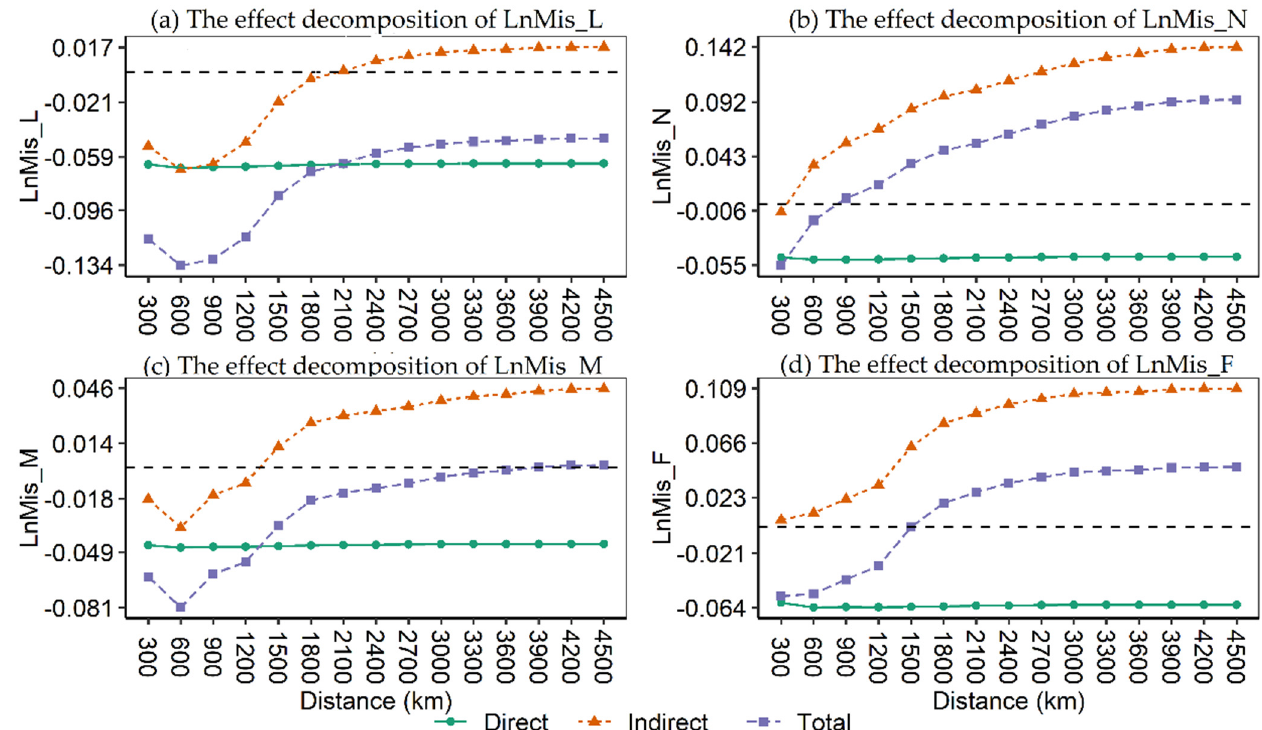
Figure 4. Direct, indirect and total effects with changing geographical distance. The black dash line denotes 0 value line.